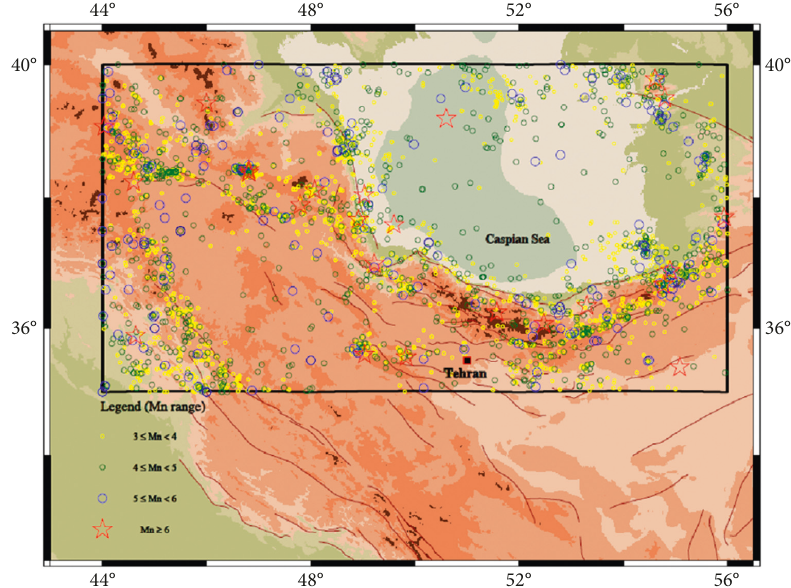
Figure 1: The seismicity map of Alborz-Azerbaijan seismic province and seismic locations greater than Mw >